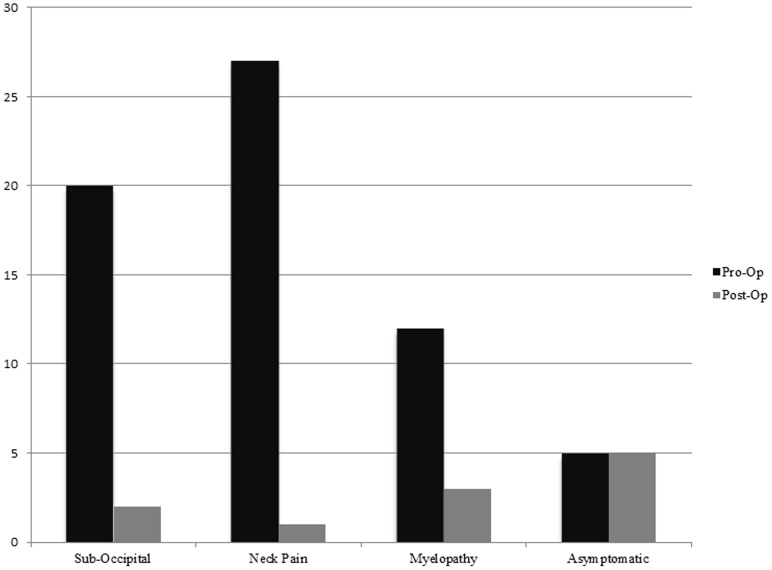
Presenting symptoms before surgery compared to after surgery.